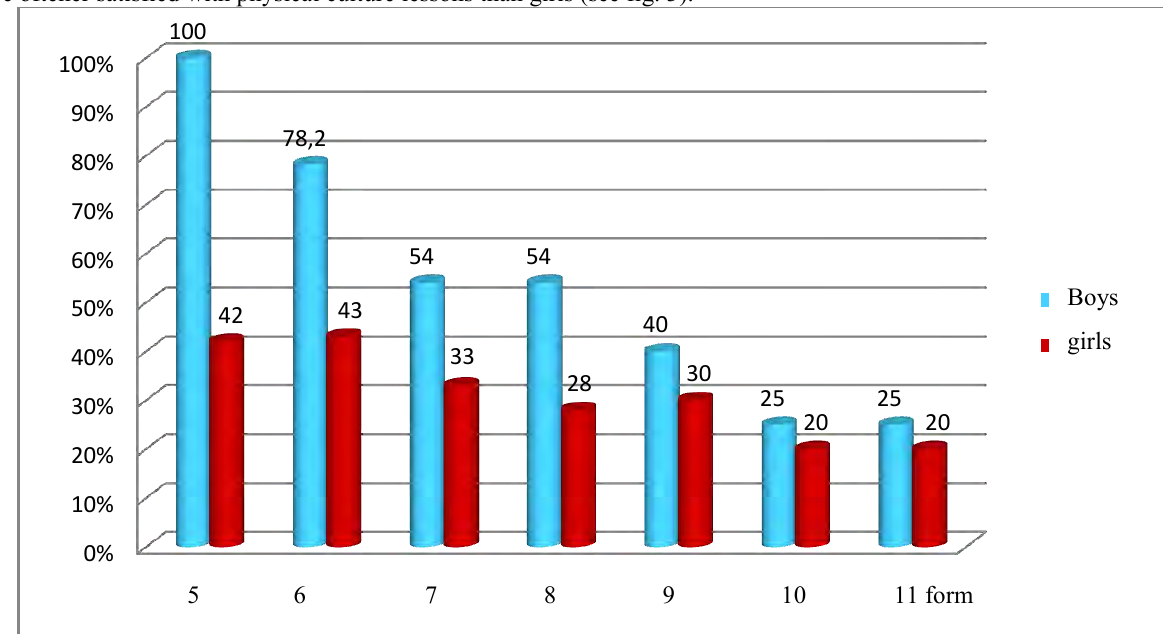
Fig.3 Indicators of 5-11 th forms pupils’ satisfaction with physical culture